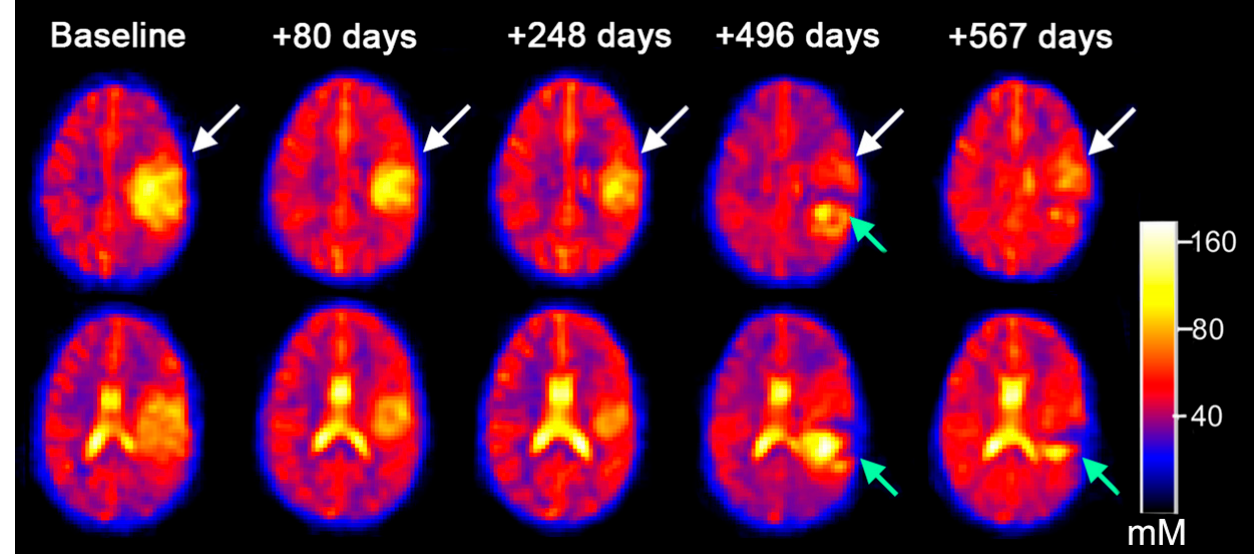
Figure 4. Serial total sodium MRI images at two different axial levels from a participant with supratentorial high-grade glioma treated with immunotherapy. This time series demonstrates a decrease in TSC relative to uninvolved tissue, preceding the eventual lesion size reduction in the tumor (white arrow) as noted by fluid-attenuated inversion recovery (FLAIR) imaging (Supplemental Figure S3). Note, a separate necrotic recurrent lesion (green arrow) also depicted in the sodium vBSC images (Supplemental Figure S5).